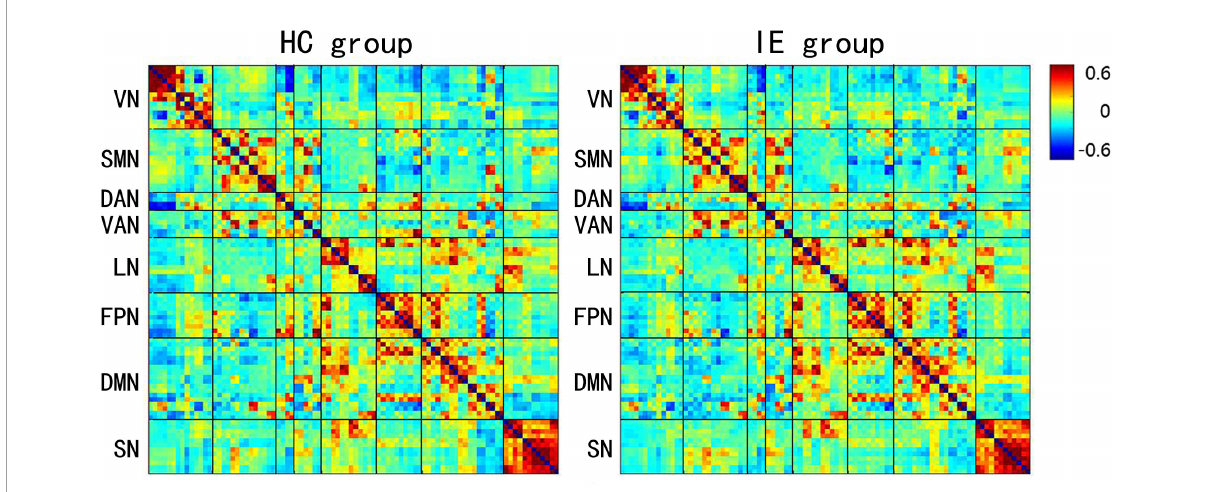
FIGURE1 Mean Z -score Matrices for Healthy Subjects and Patients with Infantile Esotropia. Each figure exhibits a 90 × 90 square matrix. The colored bar indicates the z -score of the functional connectivity. HC, healthy control; IE, infantile esotropia; VN, visual network; SMN, sensorimotor network; DAN, dorsal attention network; VAN, ventral attention network; LN, limbic network; FPN, frontoparietal network; DMN, default mode network; SN, subcortical